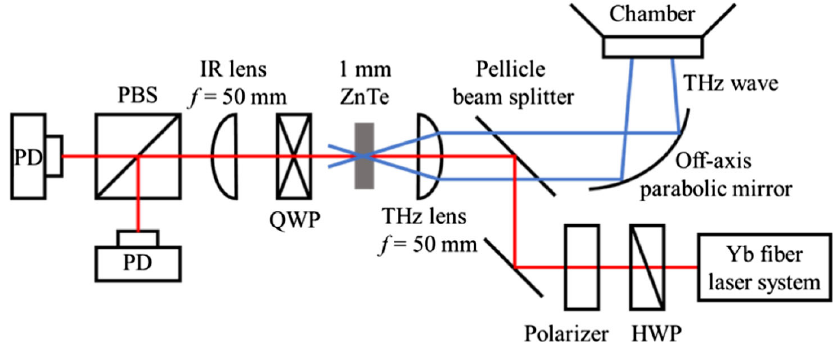
FIG. 9. Schematic of the electro-optic (EO)-sampling measurements. The pellicle beam splitter performs coaxial injection of the coherent Cherenkov radiation pulse (CChR) and the femtosecond laser generated by the Yb fiber laser system into the EO